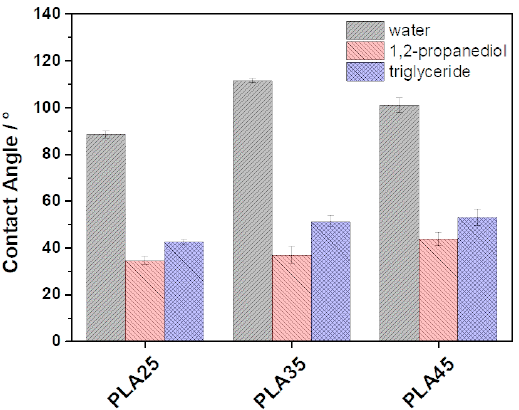
Figure 6. Contact angles for the three electrospun/electrosprayed PEG/PLA films.